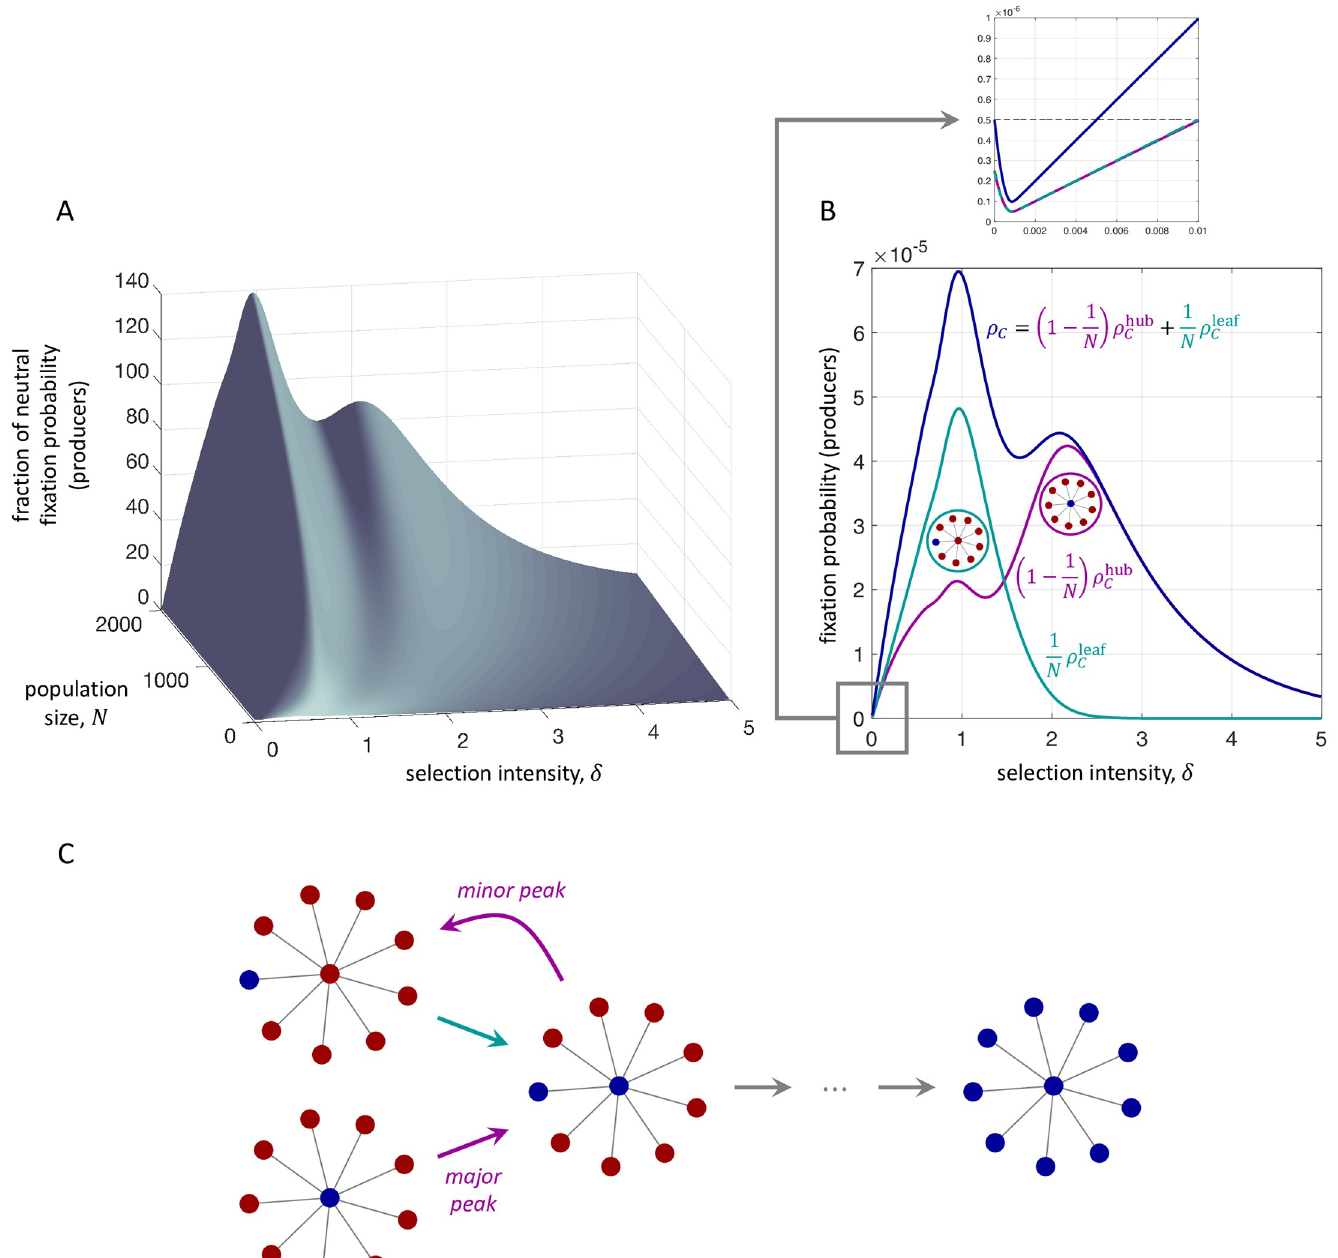
Fig 5. Fixation probability of producers of ff -goods on the star, under temperature initialization, as a function of selection intensity, δ , and population size, N (exact calculations). These curves generalize the blue curve for the fixation probability of producers in Fig 4F. A, Unlike in the case of smaller population sizes, ρ can C have multiple local maxima when N is larger. B, When N = 2000, the peak fixation probability of producers is magnified by a factor of nearly 140 over its neutral value. In the inset of B, the black dashed line represents the fixation probability under neutral drift. For all population sizes depicted here, producers are initially disfavored by weak selection (sufficiently small δ ; see inset). C, For the star, one peak can be attributed to mutant producers arising at the leaf nodes ( r leaf ), while the other can be C ). From both configurations, for the mutant type to fix the population must pass through a state with two attributed to mutant producers arising at the hub ( r hub C mutants, one at the hub and one at a leaf node. This state can revert to a configuration with a single mutant at a leaf, even when the initial mutant arises at the hub. In this case, the population is effectively starting from a different configuration, which gives rise to a minor peak corresponding to the value of δ that maximizes the probability of fixation from a leaf node. Parameters: b = 5 and c = 1.